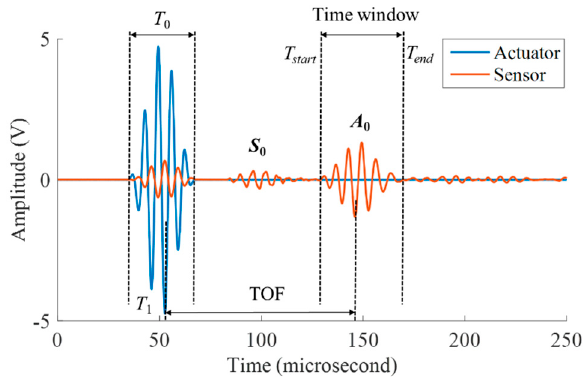
Figure 10. Schematic illustration for ToF and the time window calculation.